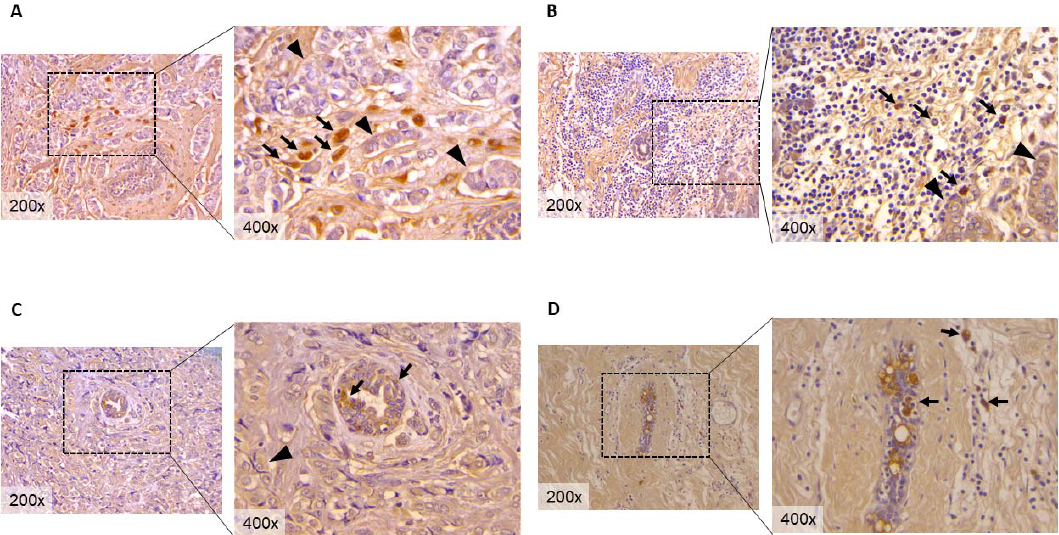
Figure 1. GL13 (SenTraGor™) immunohistochemical stain of tumor-associated fibroblasts ( A ), tumor- infiltrating lymphocytes ( B ), and cancer-entrapped normal-like mammary gland acini ( C ), in breast cancer. A post-treatment specimen (neoadjuvant setting), showing GL13 positive staining in the stroma and mammary remnants ( D ). Arrows indicate GL13 positive staining, while arrowheads depict breast-cancer cells. SenTraGor™ (GL-13) immunohistochemical staining was performed, in accordance with the instructions of the manufacturer and as previously described